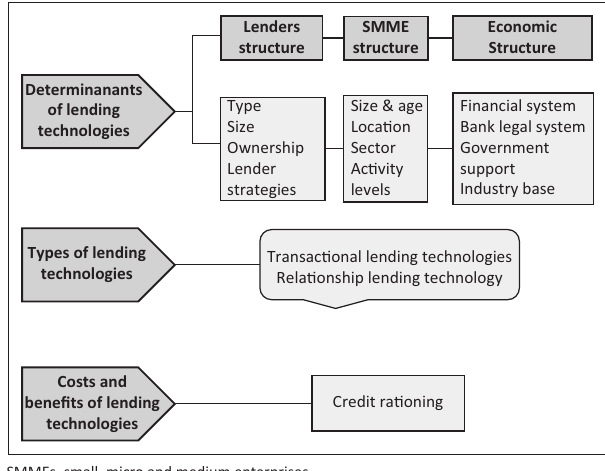
FIGURE 1: Small, micro and medium enterprises lending